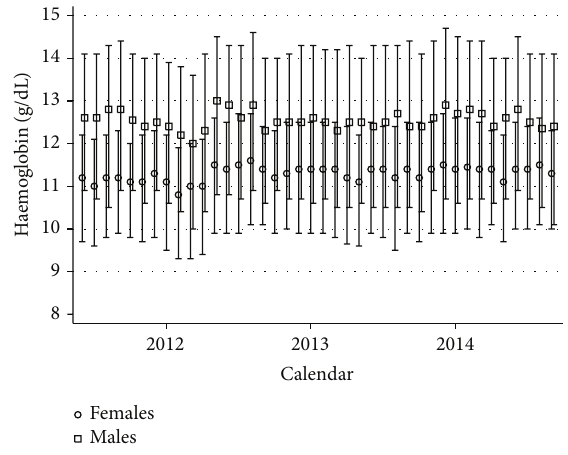
Figure 1: Median and interquartile range of haemoglobin concen- tration stratified by gender and calendar